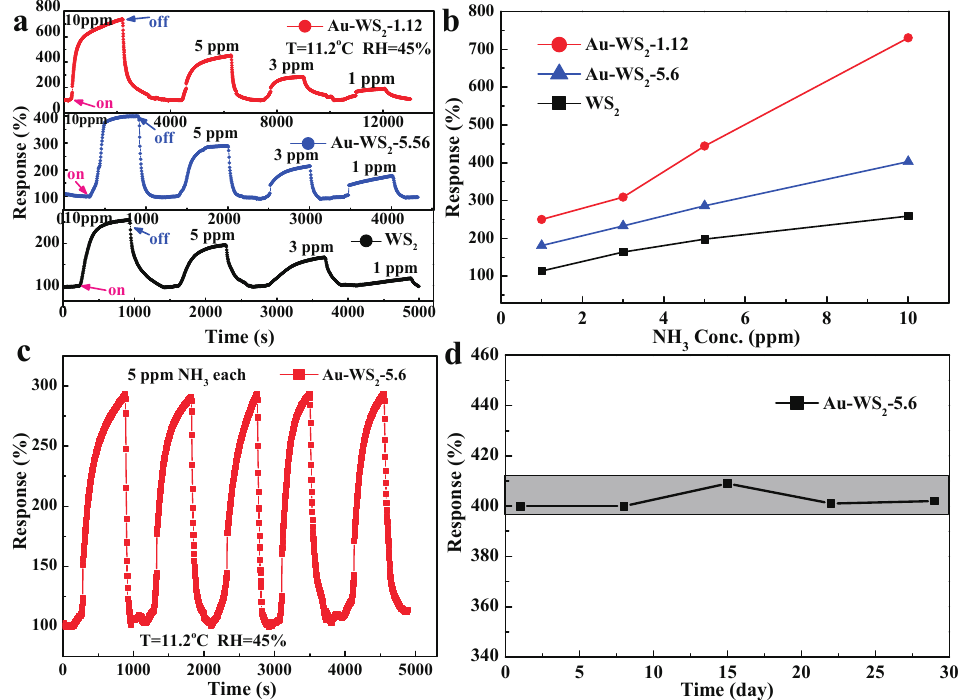
Figure 8. ( a , b ) Gas sensor responses to different concentrations of ammonia of Au/WS 2 -1.12, Au/WS 2 -5.56 and pure WS 2 ; ( c ) repeatability of gas sensor response to 5 ppm ammonia; ( d ) long-term stability of Au/WS 2 -5.6-based gas